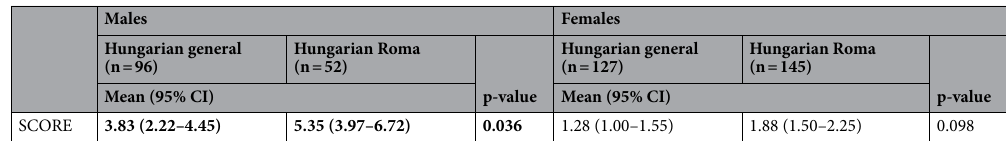
Table 5. Results of SCORE in the 40–64-year-old Hungarian general and Hungarian Roma populations. Significant differences in mean or prevalence rates are highlighted in